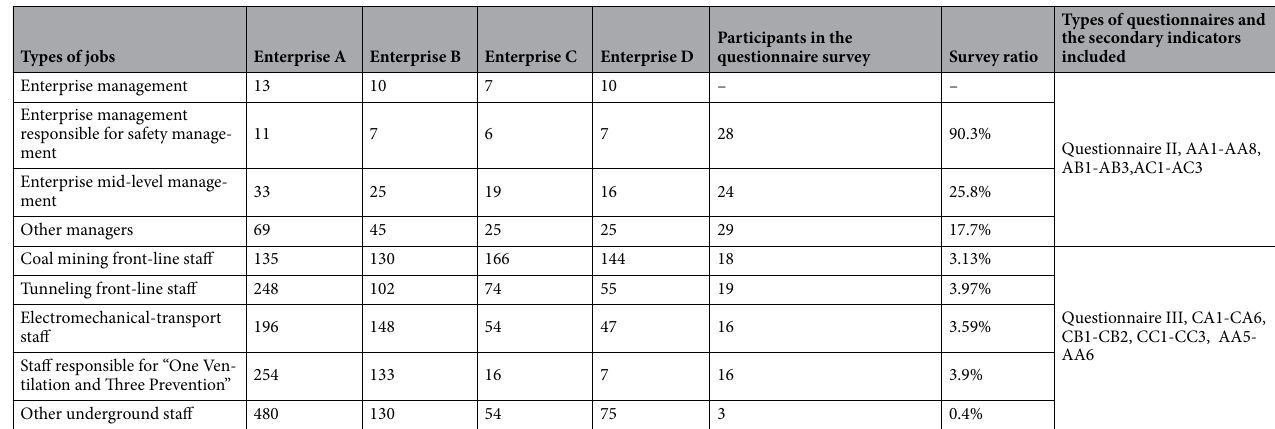
Table 5. Number of participants in questionnaire II,